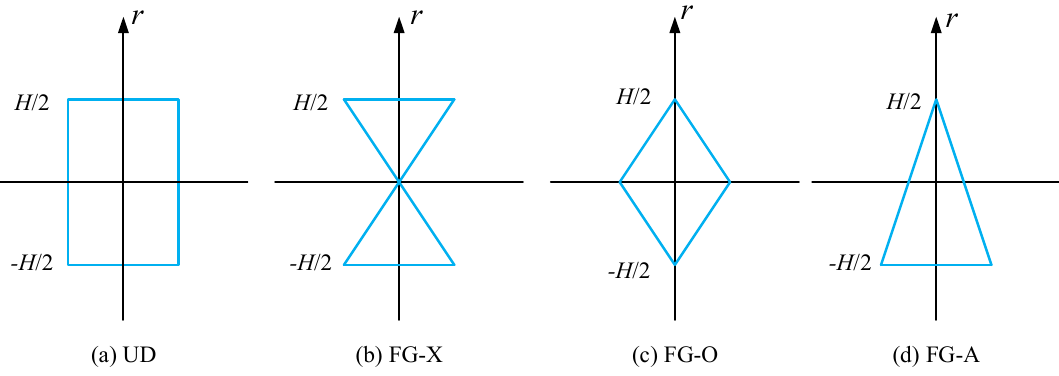
Figure 2. GPL distribution patterns along the thickness of the FG-GPLRC circular arch.